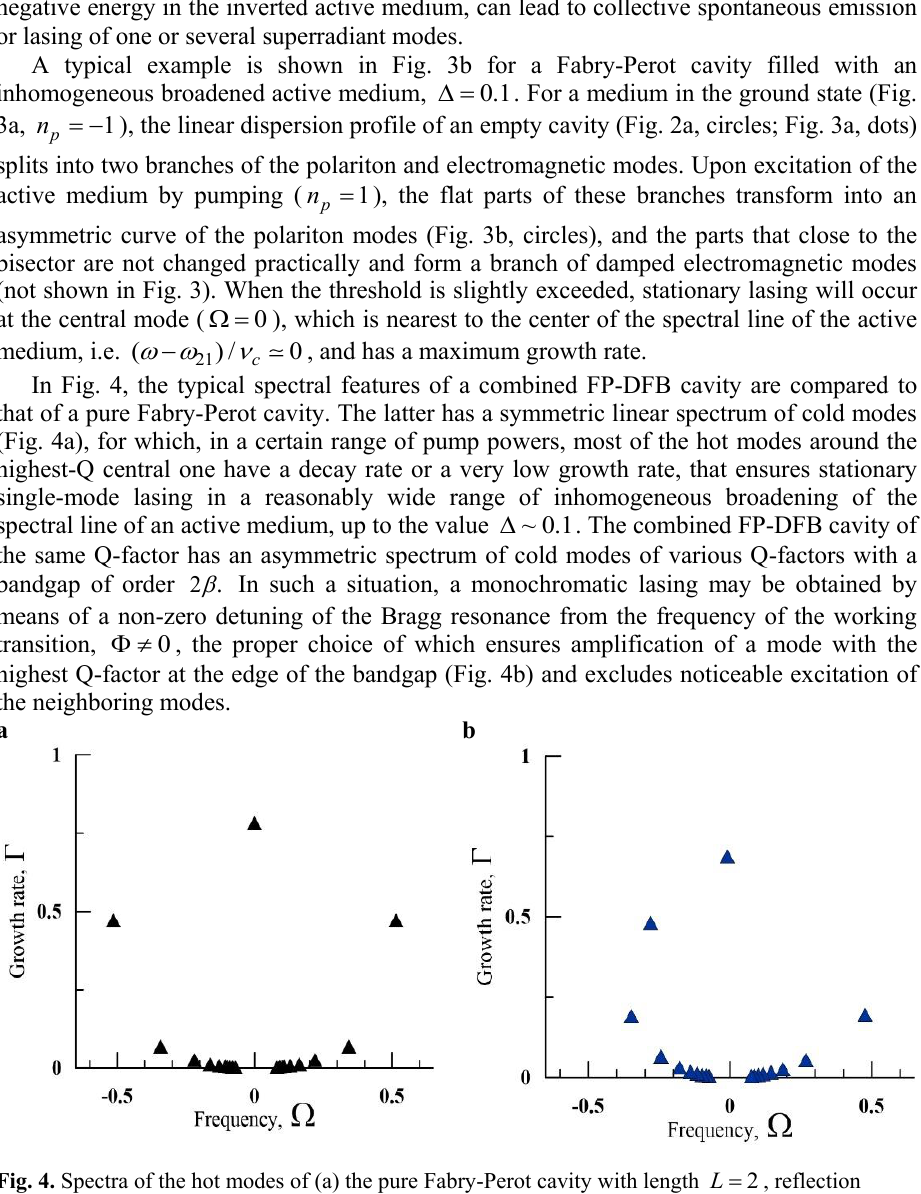
Fig. 4. Spectra of the hot modes of (a) the pure Fabry-Perot cavity with length 2 L  , reflection factor 0.37 R  , 0   and (b) the combined FP-DFB cavity of the same length and Q-factor, caused by the combination of the following parameters: reflection factor 0.2 R  , DFB parameter 1 b  , and frequency deturning between the Bragg resonance and the spectral line 0.7   . In both cases, there is a completely inverted active medium, 1 n  , with small both inhomogeneous, 0.1   , and p homogeneous, 0.02   , 2